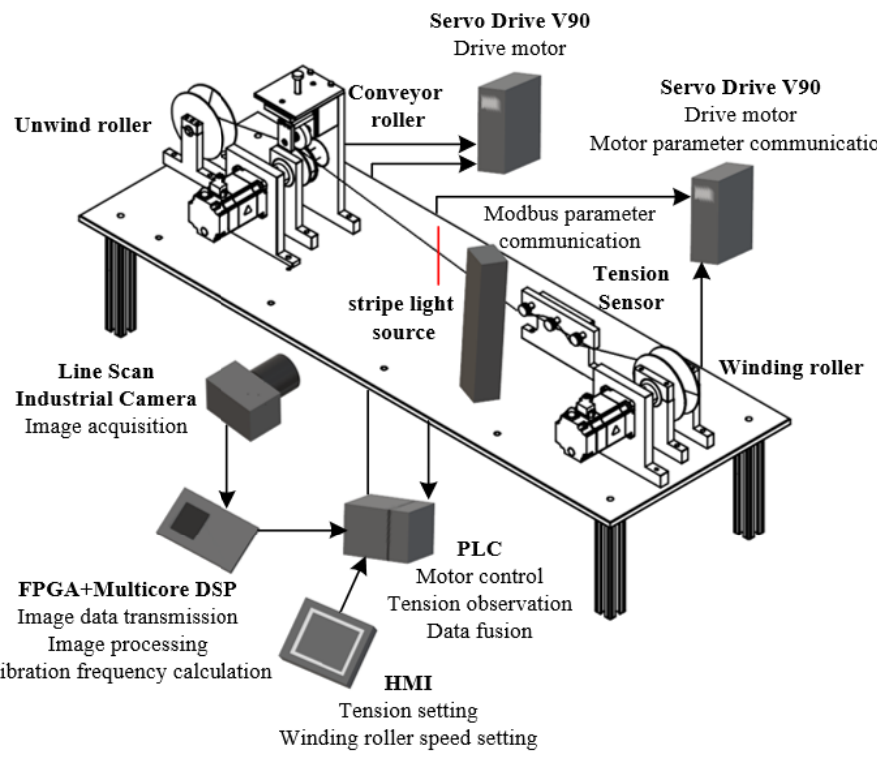
Figure 5. Mechanical structure of the detection system.